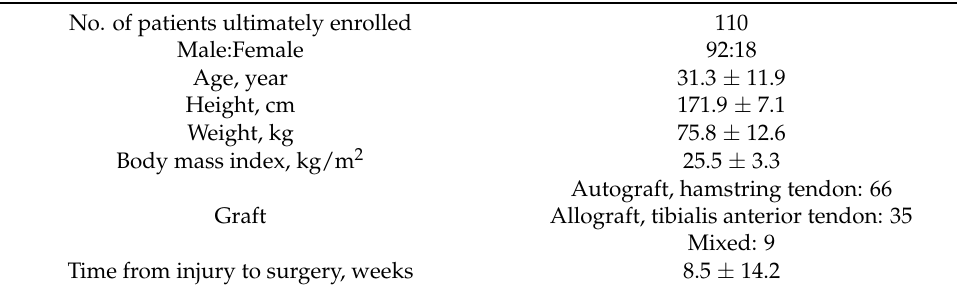
Table 1. Demographic data of all enrolled patients.